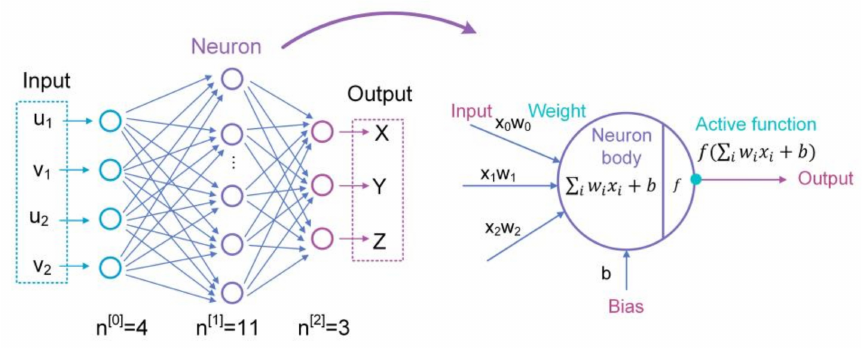
Figure 5. Structure of the constructed BP neural